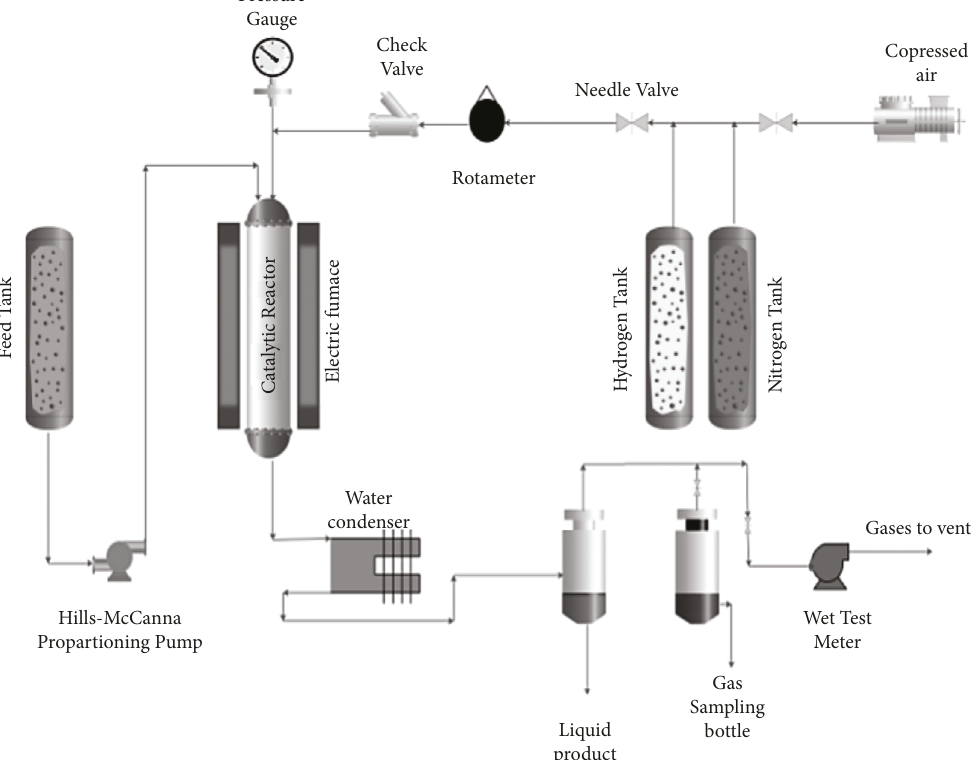
Figure 3: Experimental setup